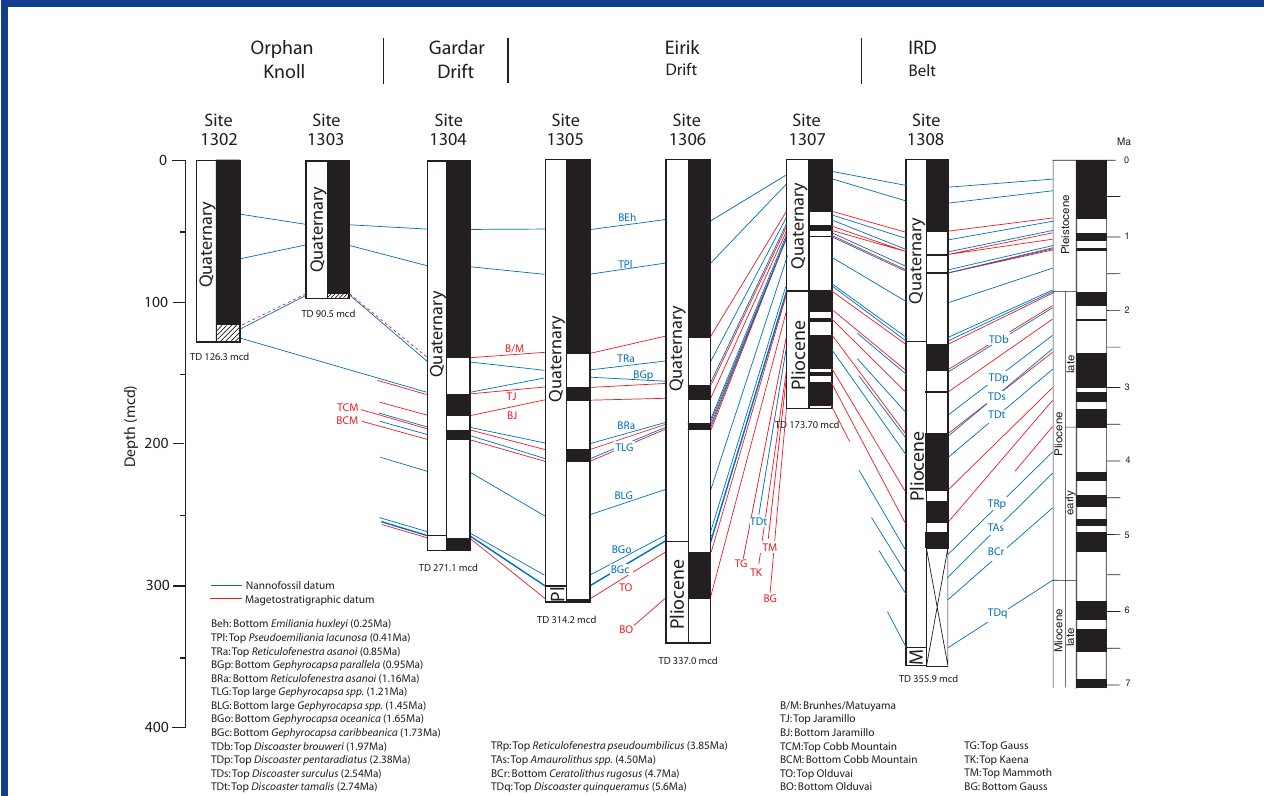
Figure 3. Schematic stratigraphy at the seven sites drilled during Expedition 303. The geomagnetic polarity timescale is shown on the right. The normal and reverse polarity zones indicated in black and white, respectively, are based on shipboard measurements after AF demagnetization in the 10–15 mT peak fi eld range. Hatched intervals indicate uncertain polarity in the debris fl ow of Sites 1302 and 1303. Blue tie lines indicate nannofossil data and correlations. Red tie-lines indicate magnetostratigraphic correlations. Reference polarity timescale in right-side column from Cande and Kent (1992,